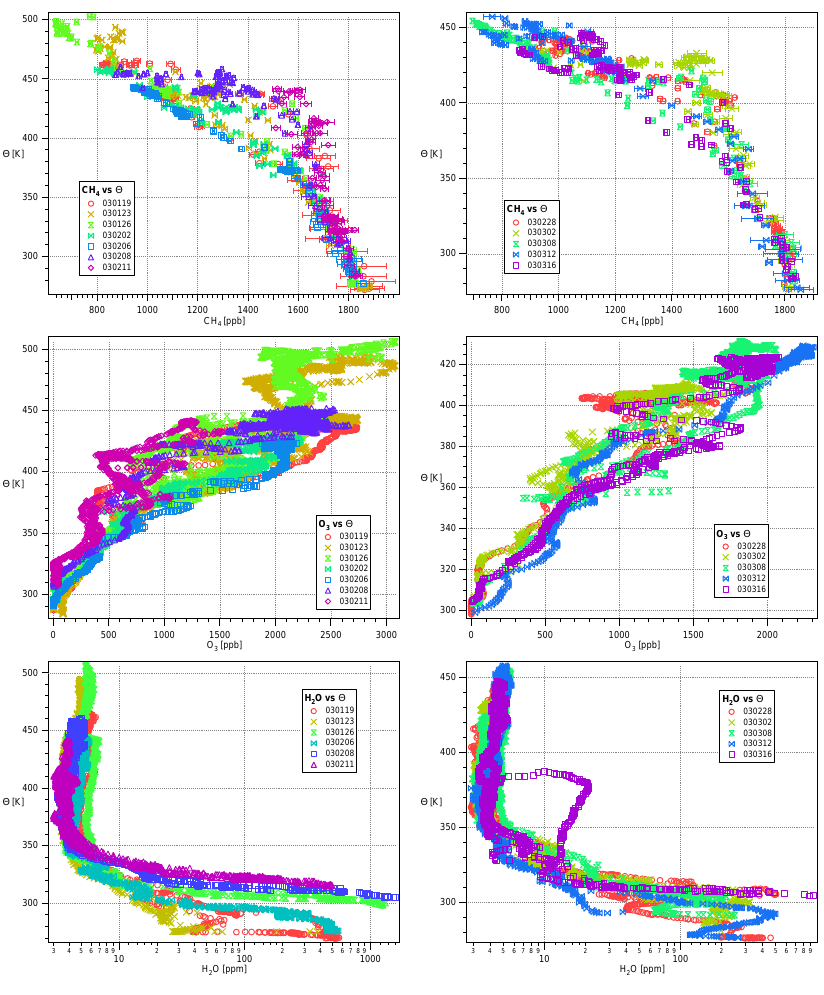
Fig. 2. Mixing ratios of CH 4 (HAGAR), O 3 (FOX) and H 2 O (FISH) plotted versus the potential temperature for all EuPLEx (left panel) and AVC flights (right panel). Error bars (HAGAR CH 4 ) denote the precision of the measurement. For O 3 the precision is 10%, for H 2 O 0.3 ppm.